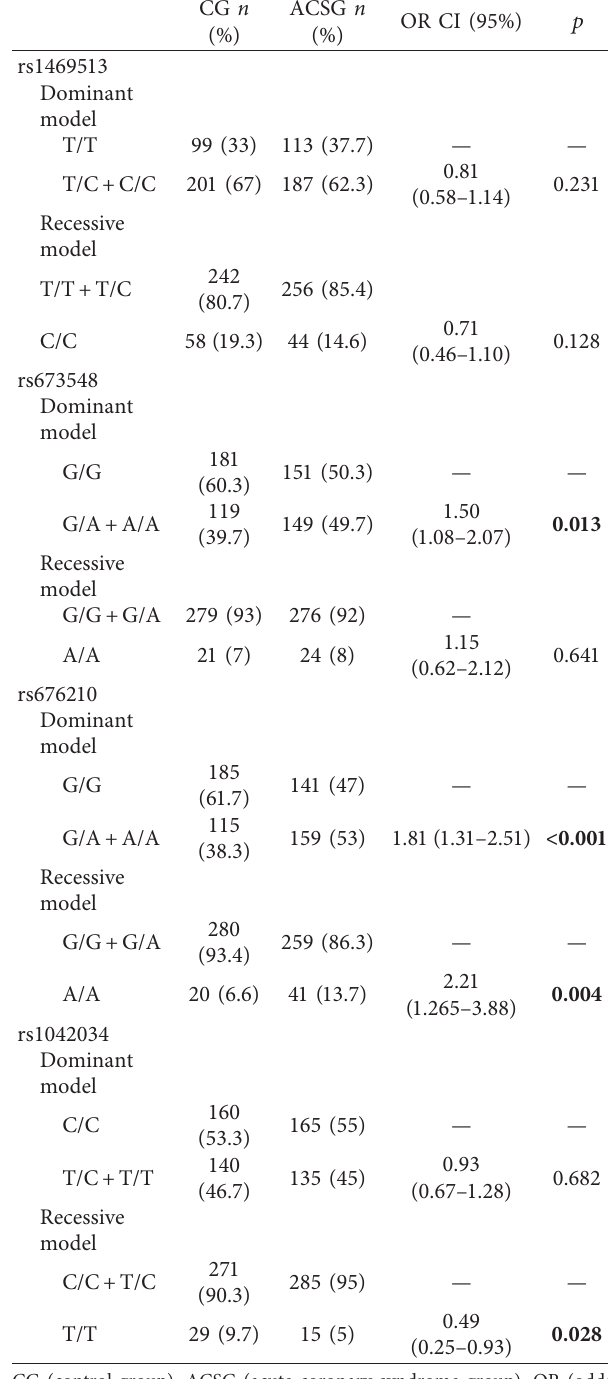
Table 4: Differences between groups of the rs1469513, rs673548, rs676210, and rs1042034 by the inheritance